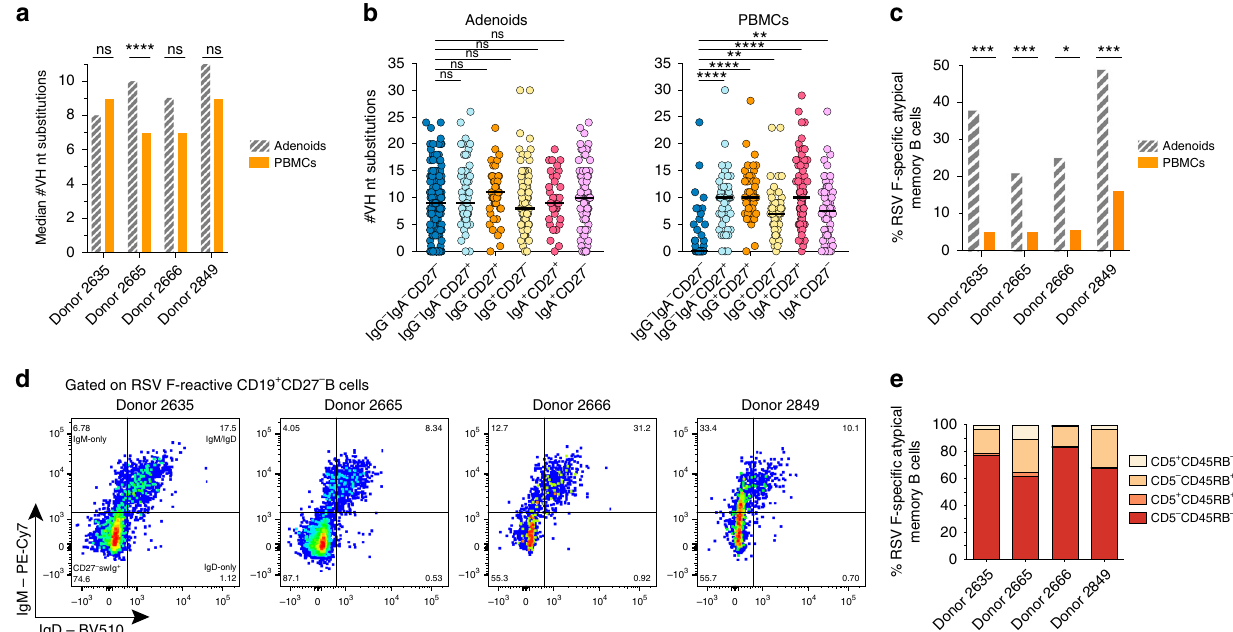
Fig. 2 Sequence characteristics of RSV F-speci fi c antibodies. a Median number of VH nucleotide substitutions in RSV F-speci fi c antibodies isolated from adenoids or PBMCs. b Number of VH nucleotide substitutions in antibodies isolated from each B cell subset. Each point represents an individual antibody. Black bars indicate median values. c Percentage of RSV F-speci fi c atypical memory B cells (de fi ned as CD19 + IgG — IgA — CD27 — and containing SHM) in adenoids and peripheral blood. d Percentage of RSV F-speci fi c CD19 + CD27 — B cells in the adenoids of each donor that are class-switched or express IgM and/or IgD. e Percentage of CD19 + RSV-F + CD27 — IgM + /IgD + adenoid B cells expressing CD5 or CD45RB MEM55 . Statistical comparisons were made using the Mann-Whitney test and Fisher ’ s exact test (**** P < 0.0001, *** P < 0.001, ** P < 0.01, * P < 0.05, n.s. not signi fi cant). Nt, nucleotide; swIg, switched